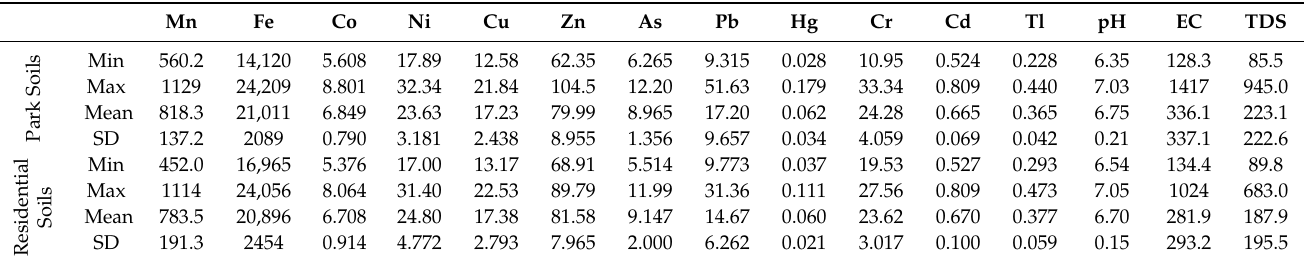
Table 1. Statistical distribution of physicochemical parameters and heavy metal levels ( µ g/g) in acid extracts of the